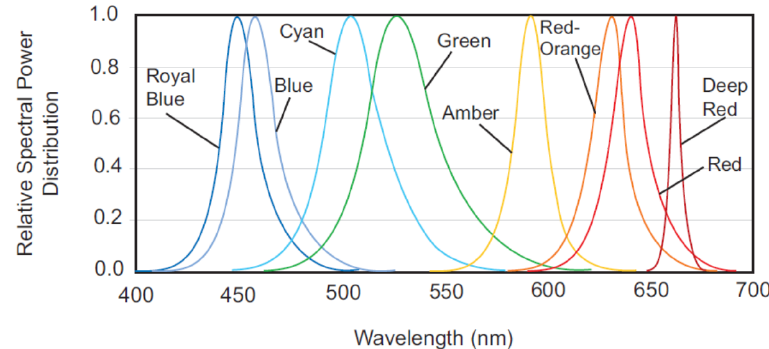
Figure 4. The relative spectral power distribution of the Philips Luxeon Rebel LEDs used in this